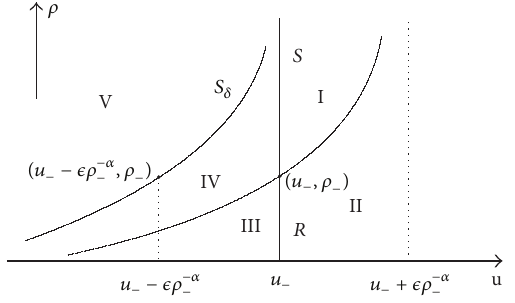
Figure 2: The upper half (𝑢, 𝜌) plane with 𝑝 = 𝜌 𝛼 (0 < 𝛼 < 1) is divided into 5